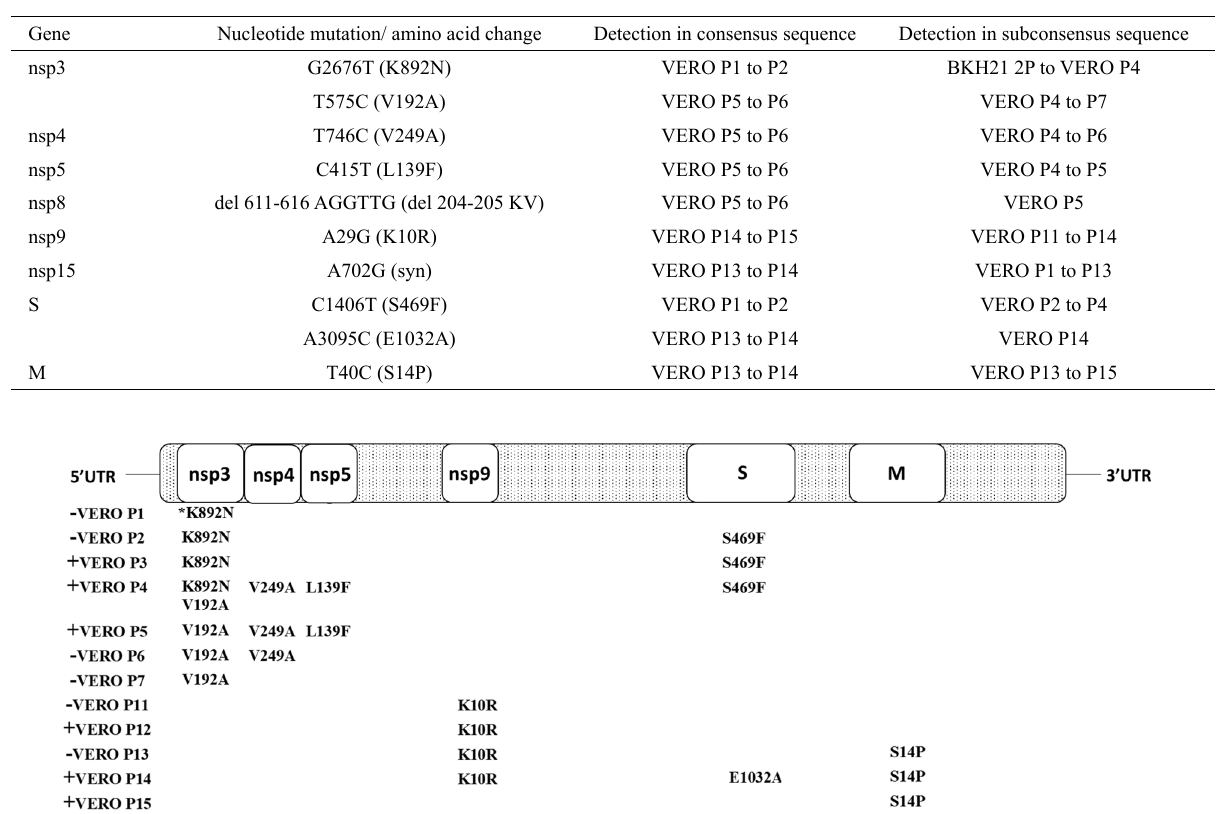
Figure 1 – A cartoon representation of Avian coronavirus genome with the genes (not in scale) showing the positions and the amino acid states (to the right of the position numbering) found in variants regarding the dominant amino acids states (to the left the position numbering) after 15 passages of the Beaudette strain in VERO cells. - =decrease in virus load; + = rise in virus load; *= also found in the ancestor virus (BHK-21 2 nd passage).